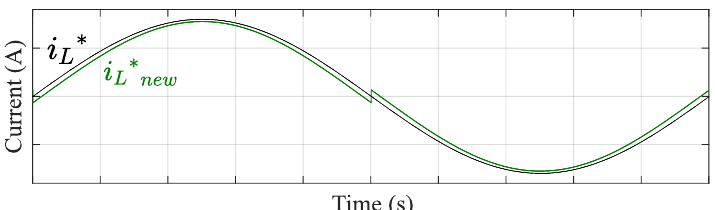
Figure 11. Sketch of sinusoidal reference and the reference corrected by variable offset.